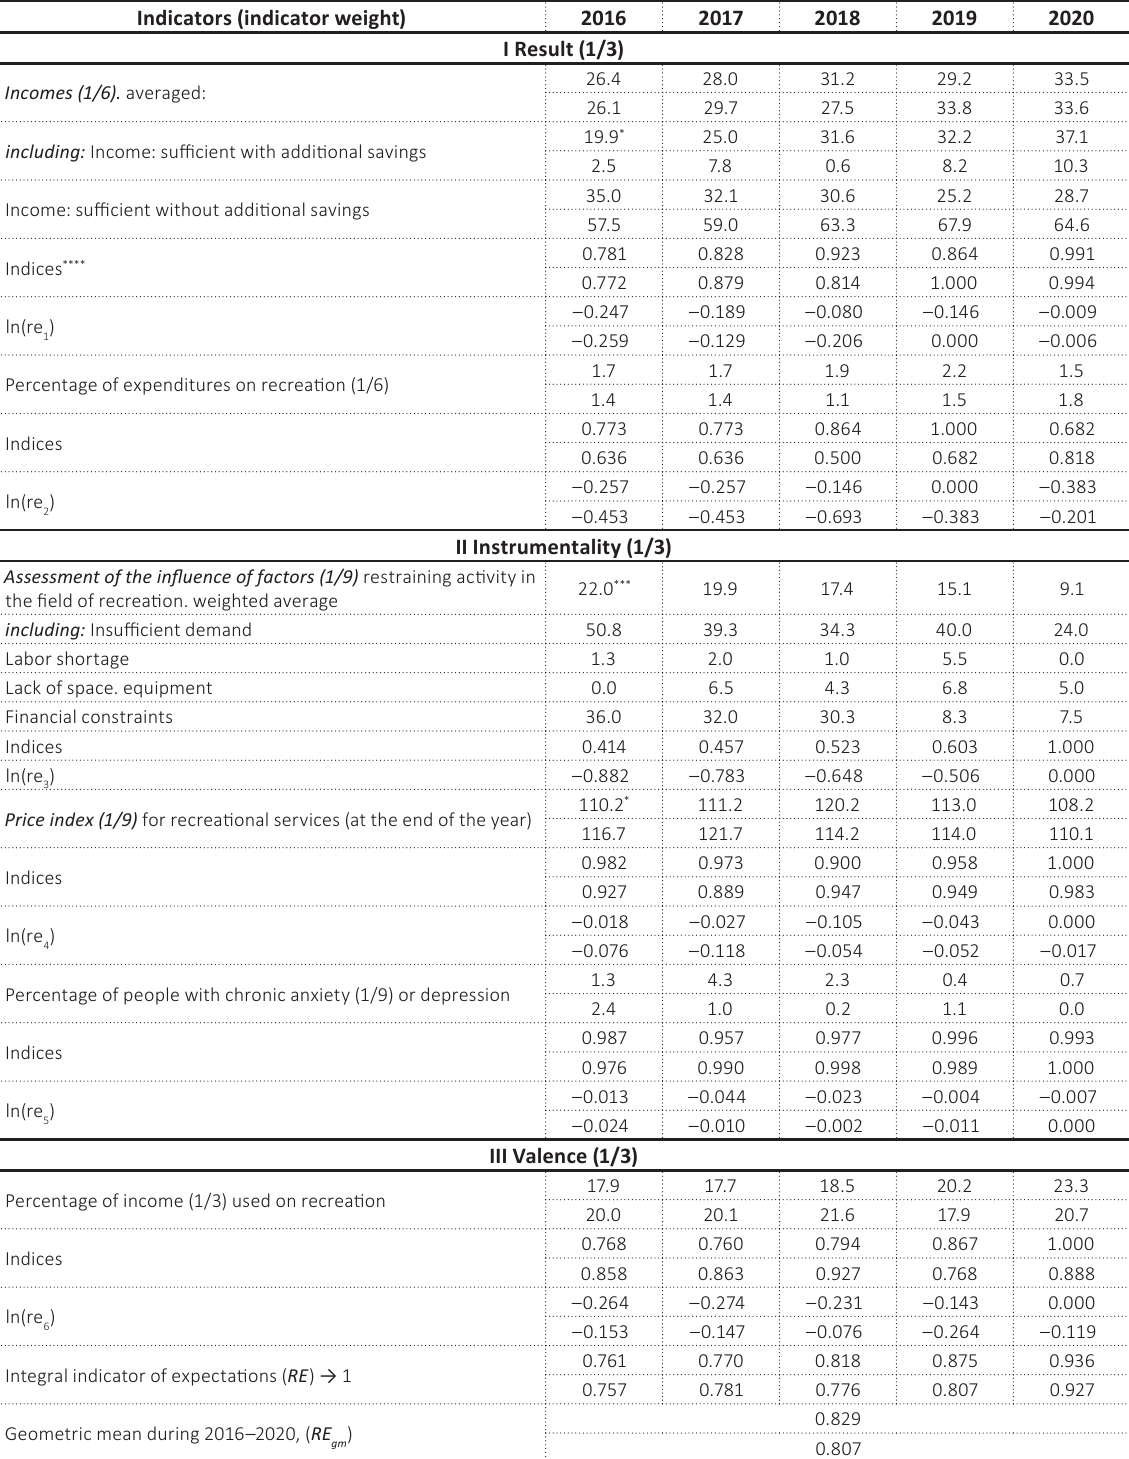
Table A1. Comparative assessment of recreational expectations, using the example of Odesa